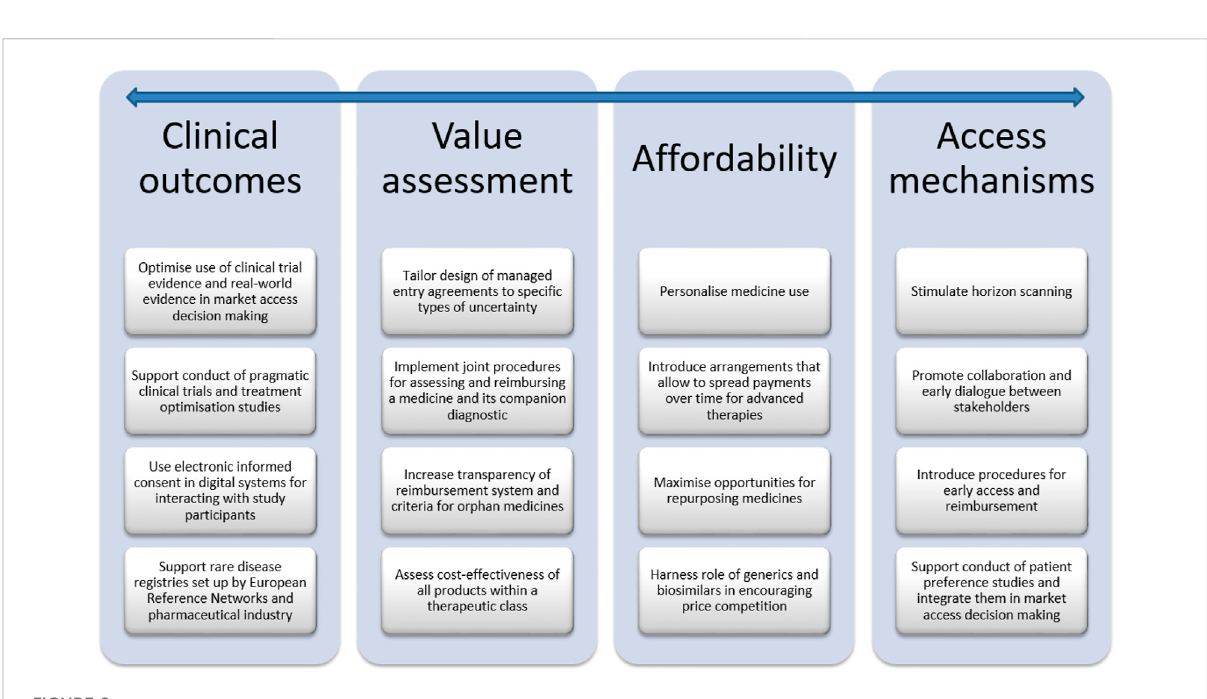
FIGURE 2 Avenues for balancing valuable innovation with affordable access to